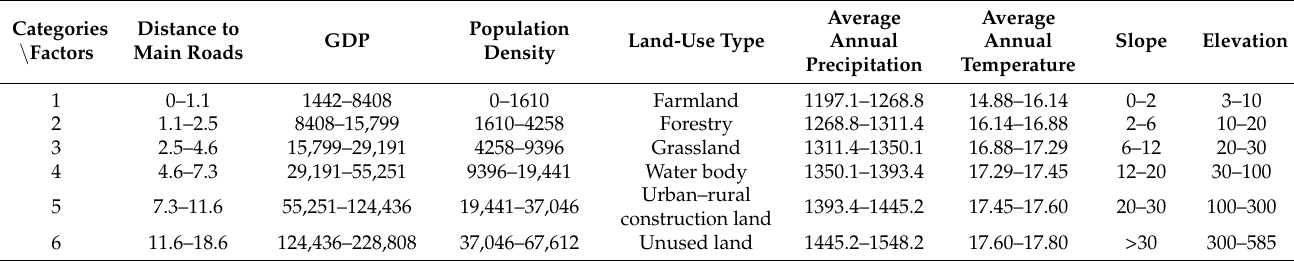
Figure 3. Spatial distribution characteristics of natural and anthropogenic factors in Wuxi area, 2020: factorial distribution of distances from major roads ( a ), GDP ( b ), population density ( c ), land use type ( d ), average annual precipitation ( e ), average annual temperature ( f ), slope ( g ) and elevation ( h ). Table 3. Factors grading Table 2. Influencing factors of small and micro wetlands change.